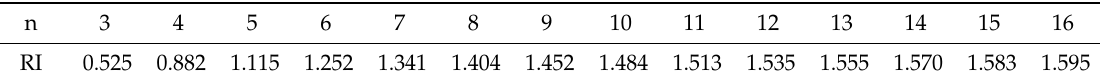
Table 2. Randomized index of randomization